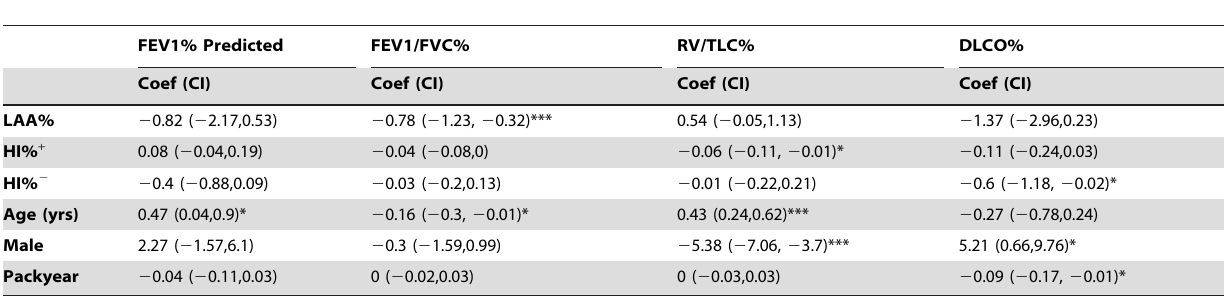
Table 5. Multiple linear regression model for pulmonary function measures among subjects without COPD (n=